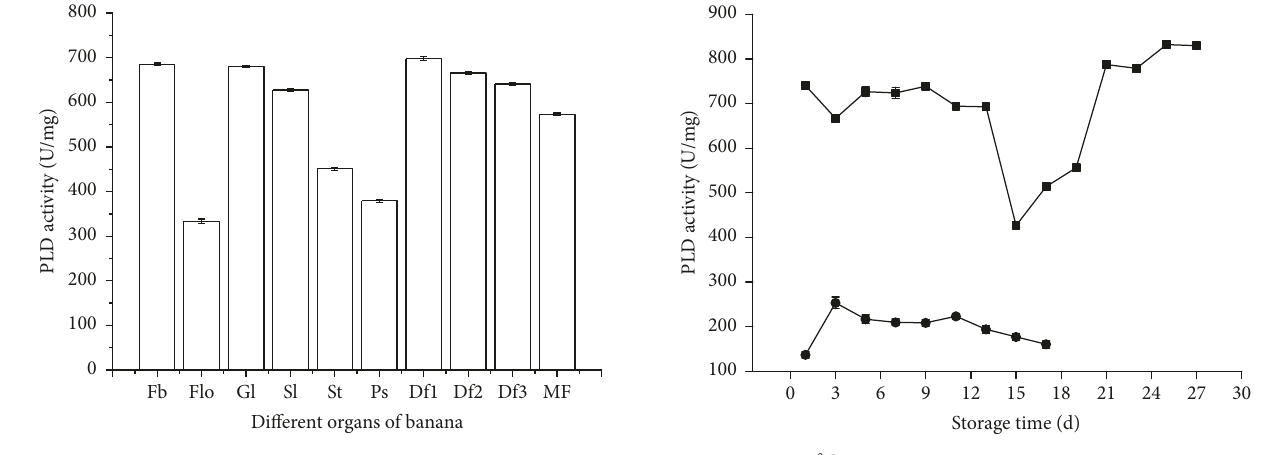
Figure 2: PLD activity of different banana organs, floral buds (Fb), flowers (Flo), green leaves (Gl), senescent leaves (Sl), pseudo stem (Ps), stem (St), developing fruits at the broken bud stage (Df1), 30 days after the broken bud stage (Df2), and 60 days after the broken bud stage (Df3), and mature fruits (Mf).